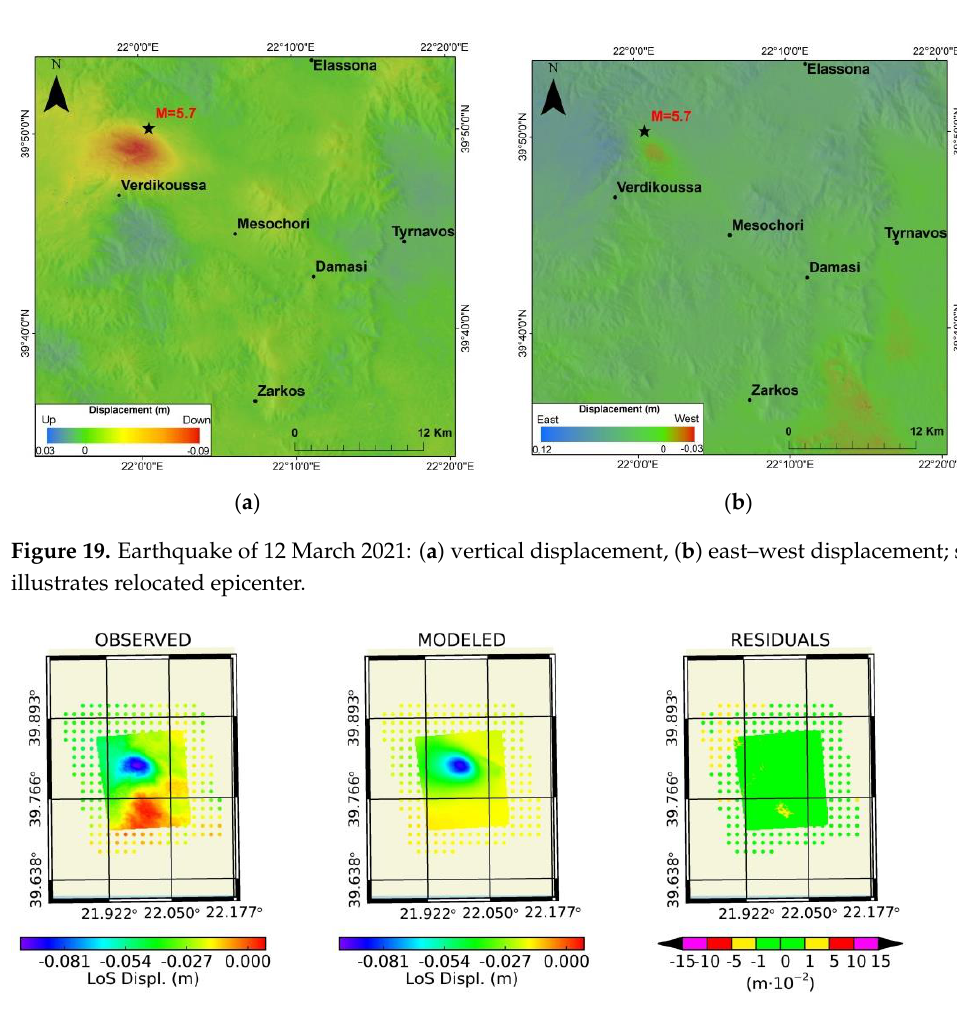
Figure 20. Comparison of LoS displacements from observed and modeled data for the third earthquake (12 March 2021) using the ascending mode.